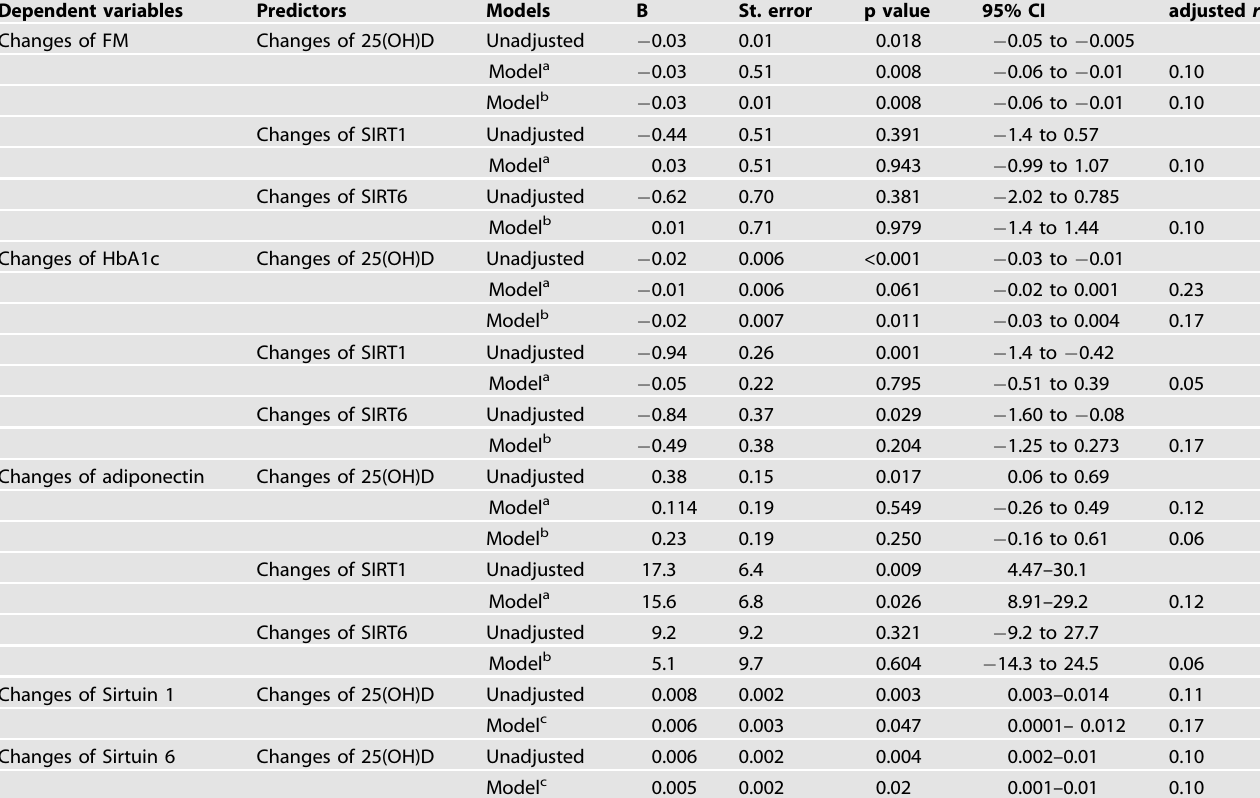
Table 5. Multiple regression results for variables after